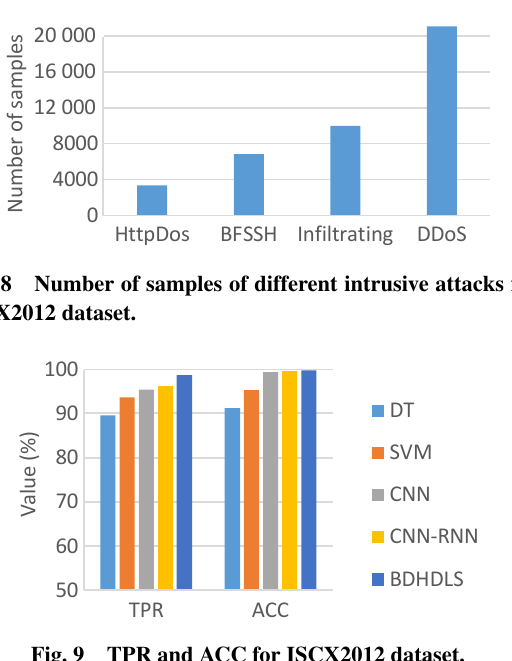
Fig. 9 TPR and ACC for ISCX2012 dataset.